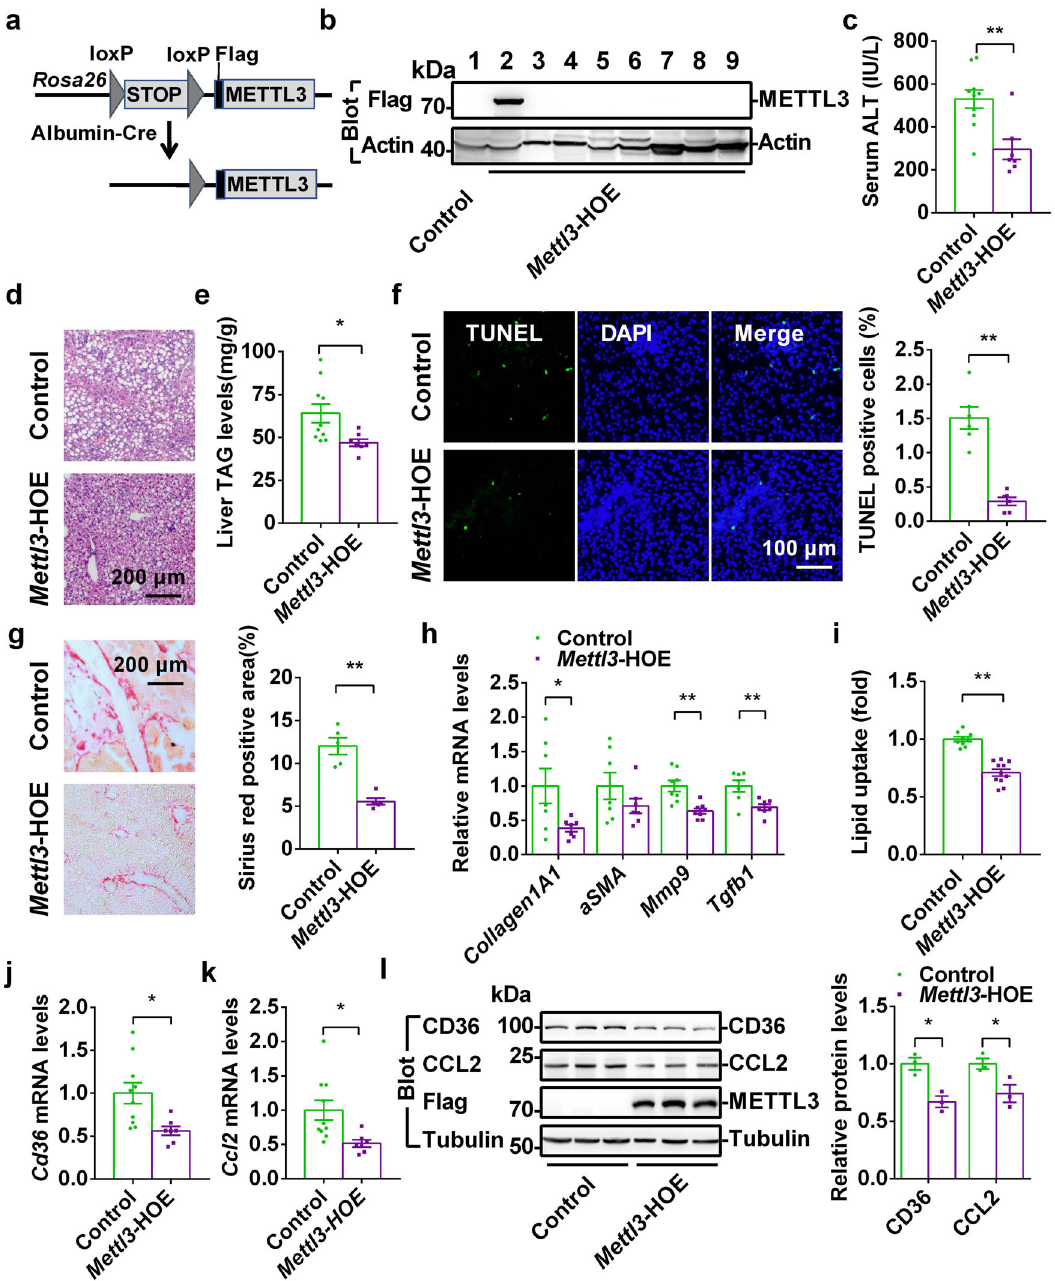
Fig. 7 Hepatic overexpression of Mettl3 ameliorates MCD-induced NASH. a A schematic representation of the Rosa26 -STOP-METTL3 targeting vector and generation of liver-speci fi c overexpression of Mettl3 mice. b Tissue extracts from control and Mettl3 -HOE mice were immunoblotted with antibodies to Flag and β -actin, respectively. Lane 1 Control liver; lane 2 HOE liver; lane 3 HOE White adipose tissue; lane 4 HOE Skeletal muscle; lane 5 HOE Brown adipose tissue; lane 6 HOE Heart; lane 7 HOE Spleen; lane 8 HOE Kidney, lane 9 HOE Brain. c Serum ALT activities (control, n = 10; Mettl3 -HOE, n = 7; P = 0.0024). d H&E staining of liver from control and Mettl3 -HOE mice fed an MCD for 2 weeks. e Liver TAG levels (control, n = 10; Mettl3 -HOE, n = 7; P = 0.0243). f TUNEL-positive cells ( n = 6 for each group; P = 0.00003). g Sirius Red staining of livers from control and Mettl3 -HOE mice fed an MCD for 2 weeks ( n = 5 for each group). h Relative mRNA levels (control, n = 7 – 8; Mettl3 -HOE, n = 7 – 8; collagen1A1, P = 0.0365; α SMA, P = 0.2169; Mmp9, P = 0.0011; Tgfb1, P = 0.0072). i The relative lipid uptake in control and Mettl3 -HOE mice at 8 weeks old (control, n = 9; Mettl3 -HOE, n = 11; P < 0.0001). j , k Cd36 and Ccl2 mRNA levels (control, n = 10; Mettl3 -HOE, n = 7; Cd36 , P = 0.0121; Ccl2 , P = 0.0178). l CD36 and CCL2 protein levels were measured by immunoblotting, quanti fi ed by ImageJ and normalized to Tubulin ( n = 3 for each group; CD36, P = 0.0101; CCL2, P = 0.0427). n was the number of biologically independent mice. The samples were derived from the same experiment and the blots were processed in parallel. Data represent the mean ± SEM. Signi fi cance was determined by unpaired two-tailed Student ’ s t test analysis. * P < 0.05. ** P < 0.01. Source data are provided as a Source Data fi